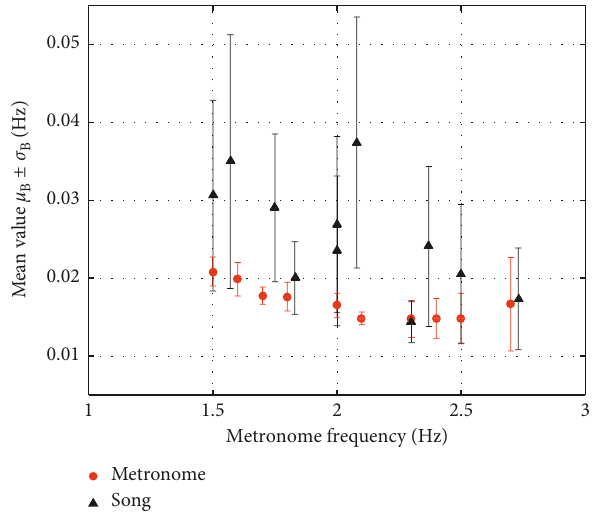
Figure 39: Comparison of the equivalent bandwidth for auditory